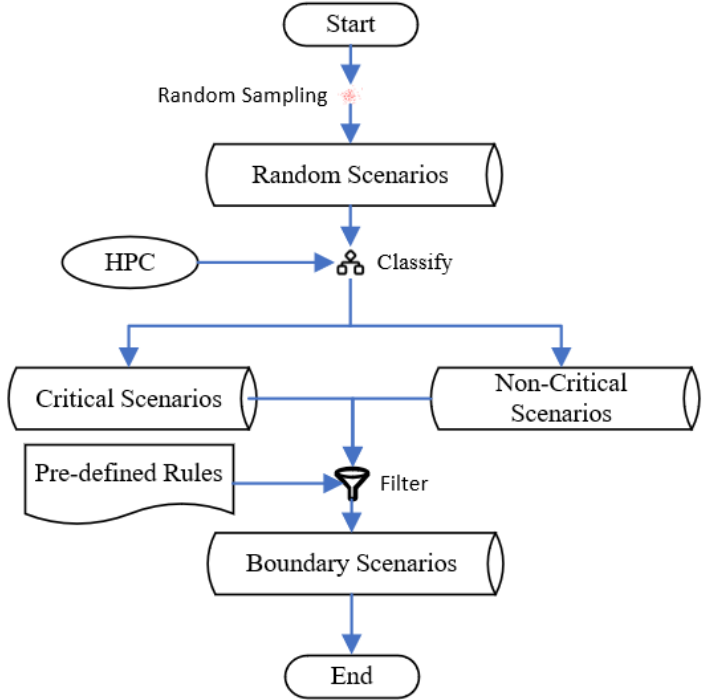
Figure 5. Flow chart of finding candidate scenarios based on one HPC.